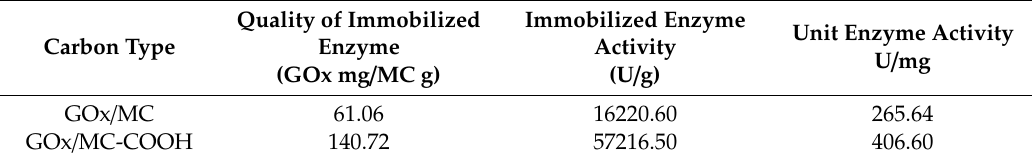
Table 2. Enzyme activity of glucose oxidase immobilized in MC and